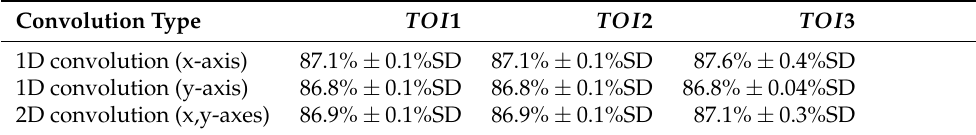
Table 4. The sensitivity depending on the convolution type and the EEG segment.